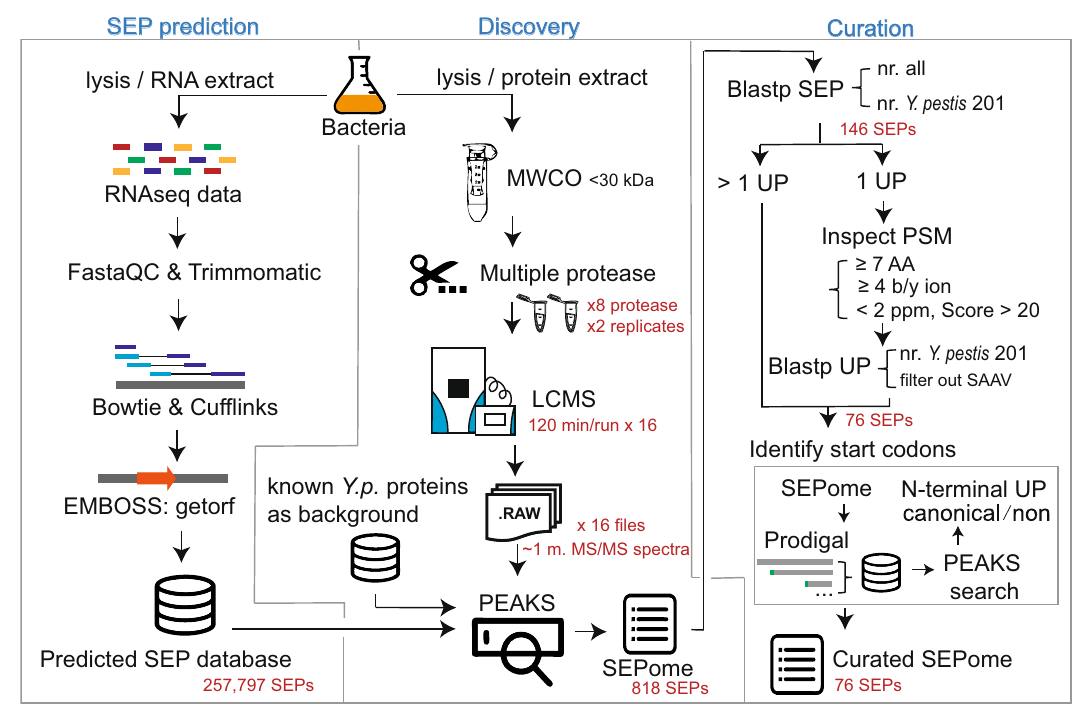
Fig. 1 The integrated work fl ow for discovery and identi fi cation of SEPs in Y. pestis . It includes three modules: prediction, discovery, and curation. In the prediction module, the RNA-seq data are processed and assembled to generate a searchable SEP database. In the discovery module, the bacteria samples were prepared by a re fi ned peptidomics approach, respectively, with eight proteases, followed by LC-MS analysis. The MS raw data were searched by PEAKS engine against the predicted SEP database with a known protein database as search background. In the curation module, the resulting SEPome was processed by BLASTP to remove the known proteins and then fi ltered at the level of peptide-spectrum match (PSM), and then the N terminus was determined to generate the fi nal SEPome. Refer to Supplementary Data 1 and 2 for the details of SEP candidates. MWCO molecular weight cut-off, UP unique peptide, AA amino acid, SAAV single amino acid